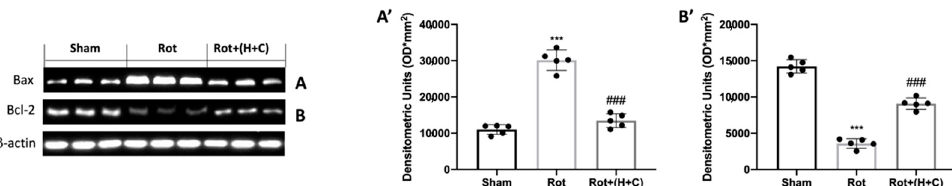
Figure 4. Effects of H+C on Bax and Bcl-2 expression after Rot intoxication. Western blot analysis demonstrated Bax expression to be significantly increased in the Rot group, whereas treatment with H+C significantly limited the rise in Bax expression ( A ). Bcl-2 expression was reduced after Rot intoxication; however, treatment with H+C restored the basal levels ( B ). See the respective densitometric graphs ( A’ , B’ ). Values are expressed as mean ± SD of three independent analyses on 5 animals/group. *** p < 0.001 compared to Sham; ### p < 0.001 compared to Rot.